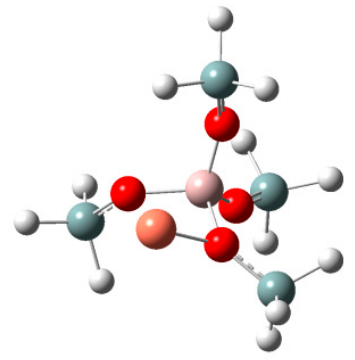
Figure 2. The model of Cu-ZSM-5.